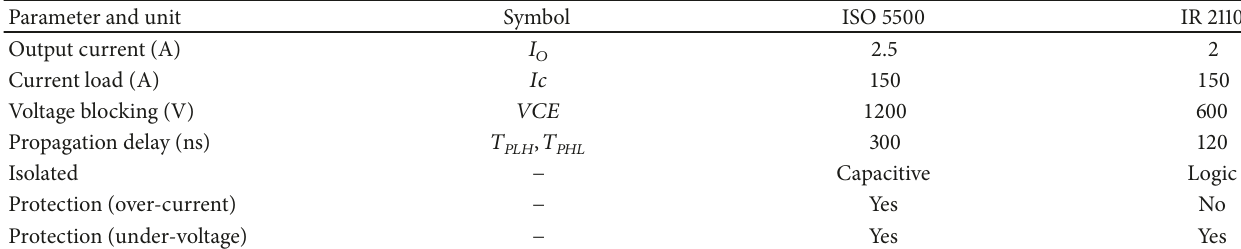
Figure 2: Block diagram of the Bi-Sw operation. Table 1: Electrics characteristics of ISO 5500 and IR